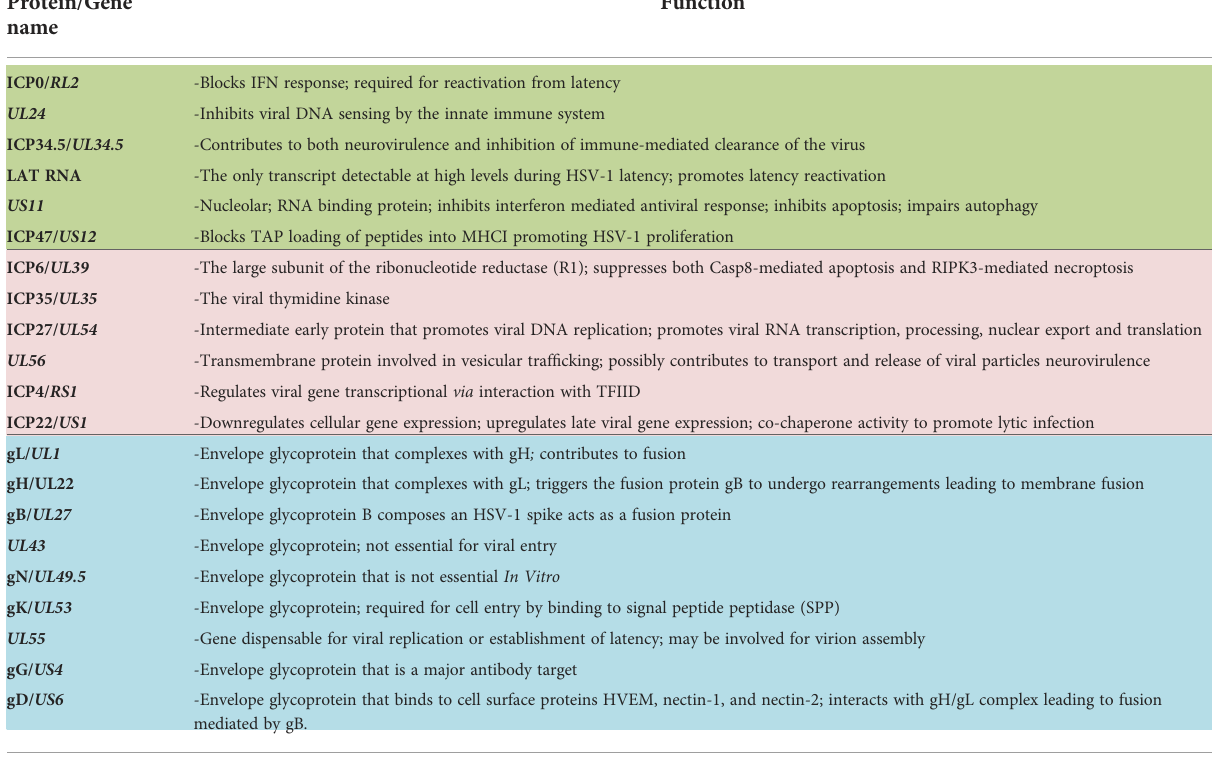
TABLE 1 HSV-1 genes modi fi ed in OV candidates. Protein/Gene name